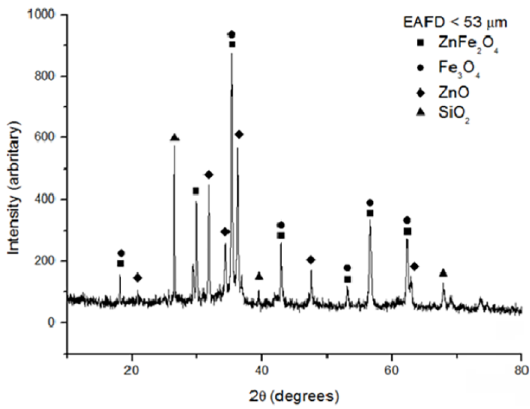
Figure 2. X-ray diffraction difractogram of